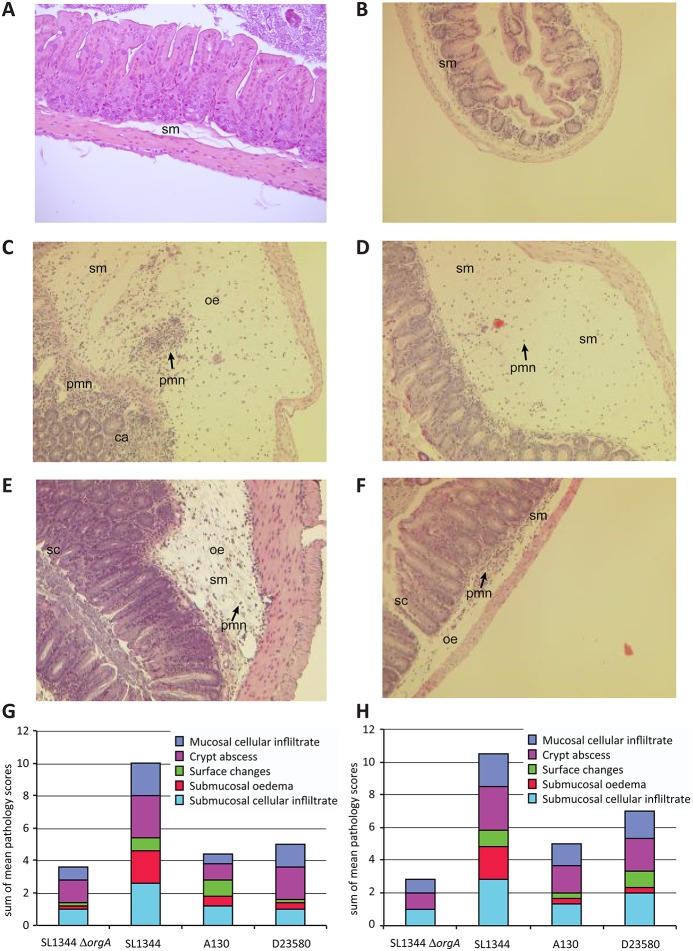
Histopathological analysis of Salmonella induced caecal inflammation of streptomycin-pre-treated mice.A single representative caecal wall image from each group is shown. A. naïve uninfected mouse. B. Infection with SL1344ΔorgA (SPI-1 mutant derivative). C & D. Infection with SL1344. E. Infection with A130 (lineage 1); F. Infection with D23580 (lineage II). Images A, C, D, E & F were taken at x100 magnification of original size (image B is x50 magnification). Abbreviations: l, intestinal lumen; sm, submucosa; oe, submucosal oedema; pmn (polymorphonuclear leukocytes) infiltrate; sc, surface changes; ca, crypt abcesses. Histopathology score of inflammatory changes in the caecum of streptomycin pretreated C57bl/6 mice (G) or 129P2/olaHsd mice (H) with ST313 isolates or strain SL1344, two or three days post inoculation. The scores of five inflammatory markers according to the key are indicated.